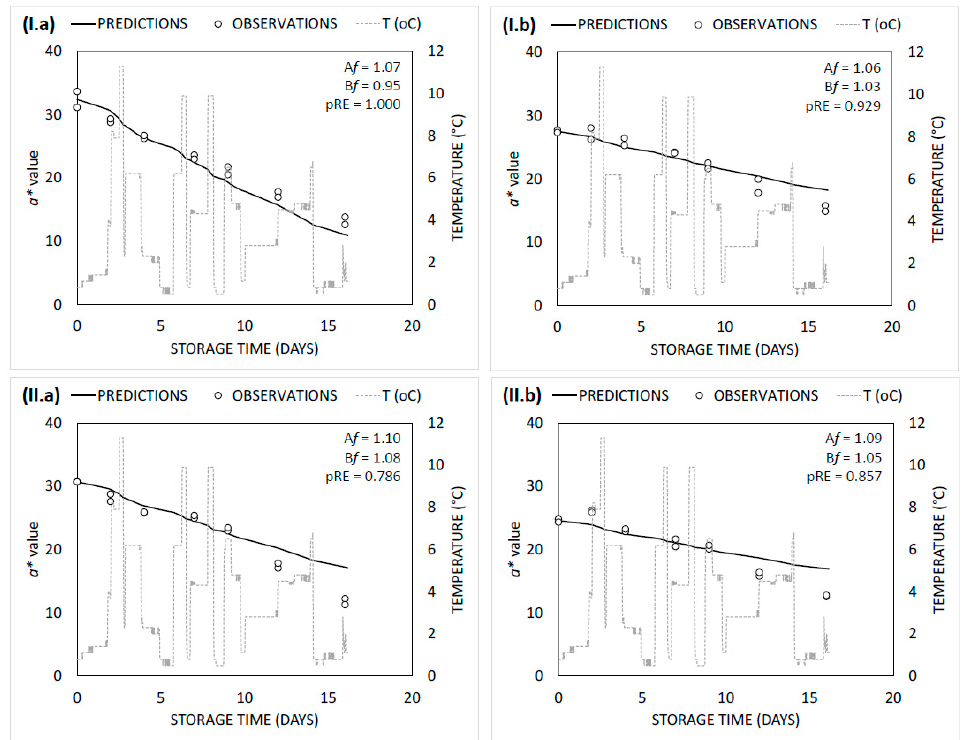
Figure 5. Simulated lines and observed data of a * value on the ( I ) surface and ( II ) bottom side of ground beef (500 g) packaged ( a ) without (controls) or ( b ) with absorbent pads supplemented with a total volume of 50 mL “ tsipouro ” (40 mL under the ground beef piece and 10 mL under the labelling, facing the headspace) under 80% O 2 : 20% CO 2 and stored at dynamic temperature conditions. Table 3. Estimated deterioration rate of a * value ( k colour (day − 1 )) and statistics on the surface and bottom side of ground beef (500 g) packaged with absorbent pads supplemented with 50 mL of “ tsipouro ” (40 mL under the ground beef piece and 10 mL under the labelling, facing the headspace) and stored at 0, 4, 8, and 12 ◦ C under 80% O 2 : 20% CO 2 . Untreated samples served as controls. Sampling Side